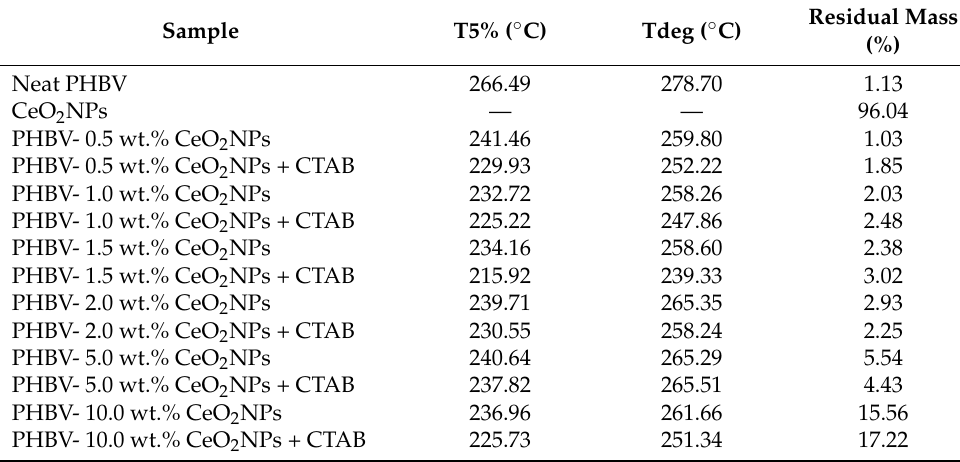
Table 3. Thermal characterization of CeO 2 NPs, and electrospun